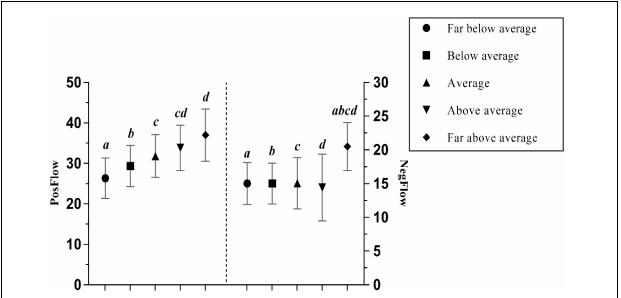
FIGURE 6 | The effects of standing among peers in the FL class on PosFlow and NegFlow (Means and Significant Differences).